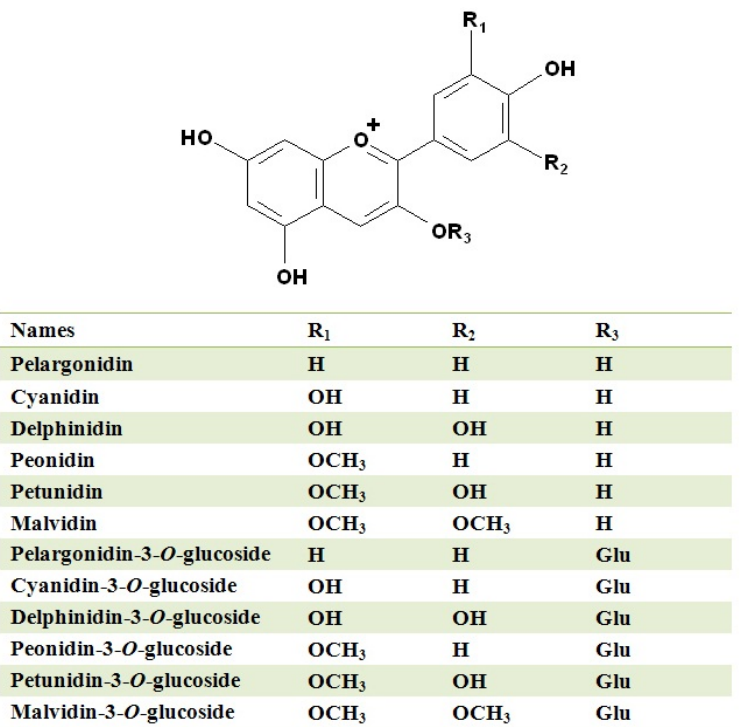
Figure 1. Structures of the monomeric anthocyanins naturally occurring in Vitis vinifera wines and their corresponding anthocyanidins